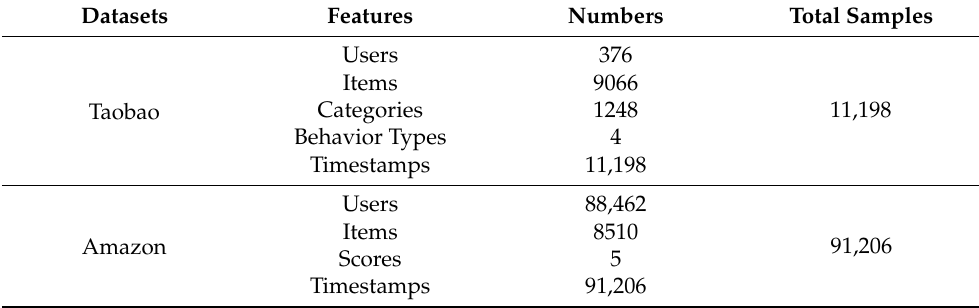
Table 1. Basic statistics for